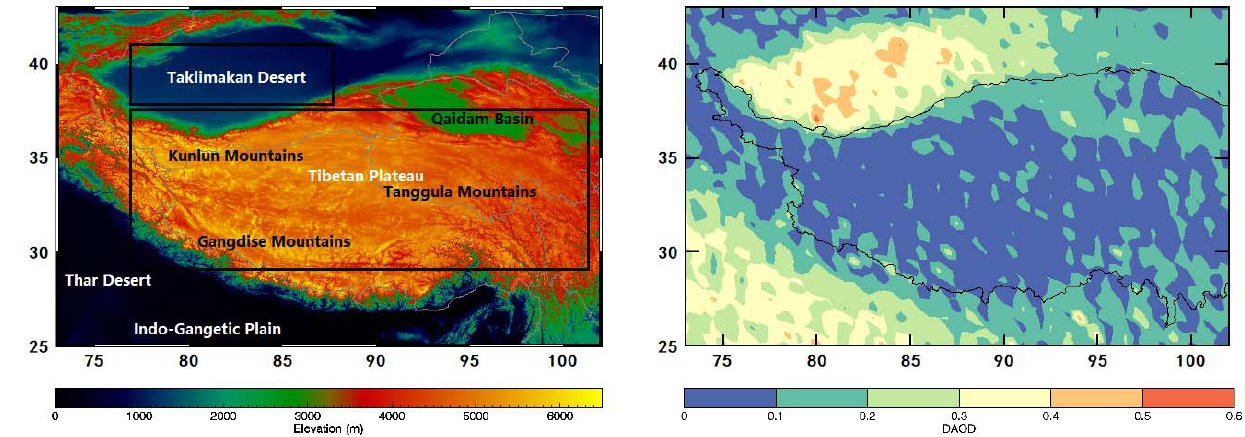
Figure 1. Topography of the study domain (73°–102° E, 25°–43° N, from SRTM30) and mean DAOD (532 nm, calculated from CALIOP/CALIPSO level 2 aerosol dataset) during 2007–2020. The two boxes define the TD (Taklimakan Desert) and TP (Tibetan Plateau) regions.